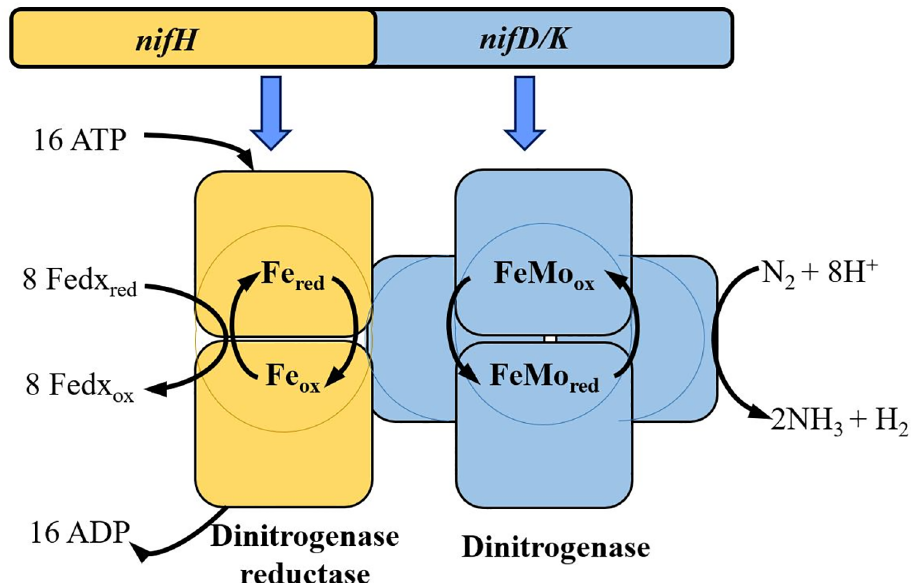
Figure 1. Nitrogenase complex. The nifHDK operon (genes encoding for the Fe/Mo-Fe nitrogenase protein complex) codifies for the subunits of the nitrogenase enzyme, which catalyzes the reduction of the N 2 to NH 4 in an ATP- dependent manner through the electron flux from the dinitrogenase reductase to the molybdenum-iron (Mo-Fe) protein subunit. Modified from Ref.